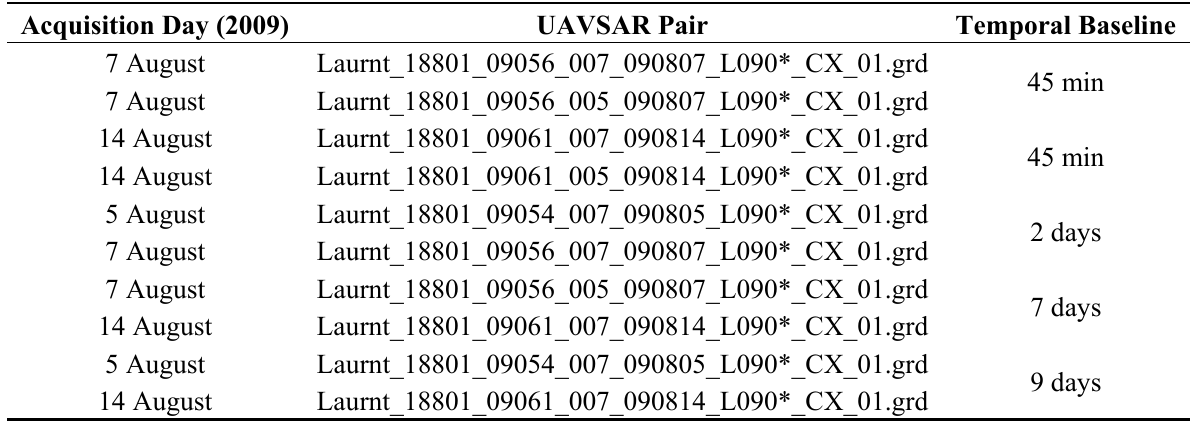
Table 1. List of zero baseline UAVSAR coherence pairs. The star (*) represents the polarization channel. Both HH and HV pairs were